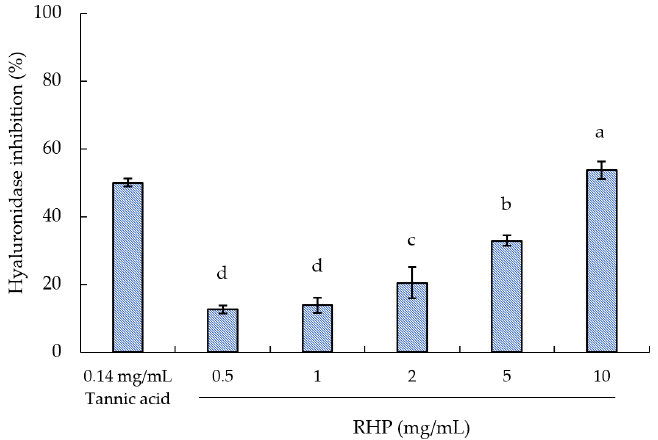
Figure 6. Effect of RPH concentration on hyaluronidase inhibitory activity. The means not sharing a common superscript are significantly different ( p < 0.05).